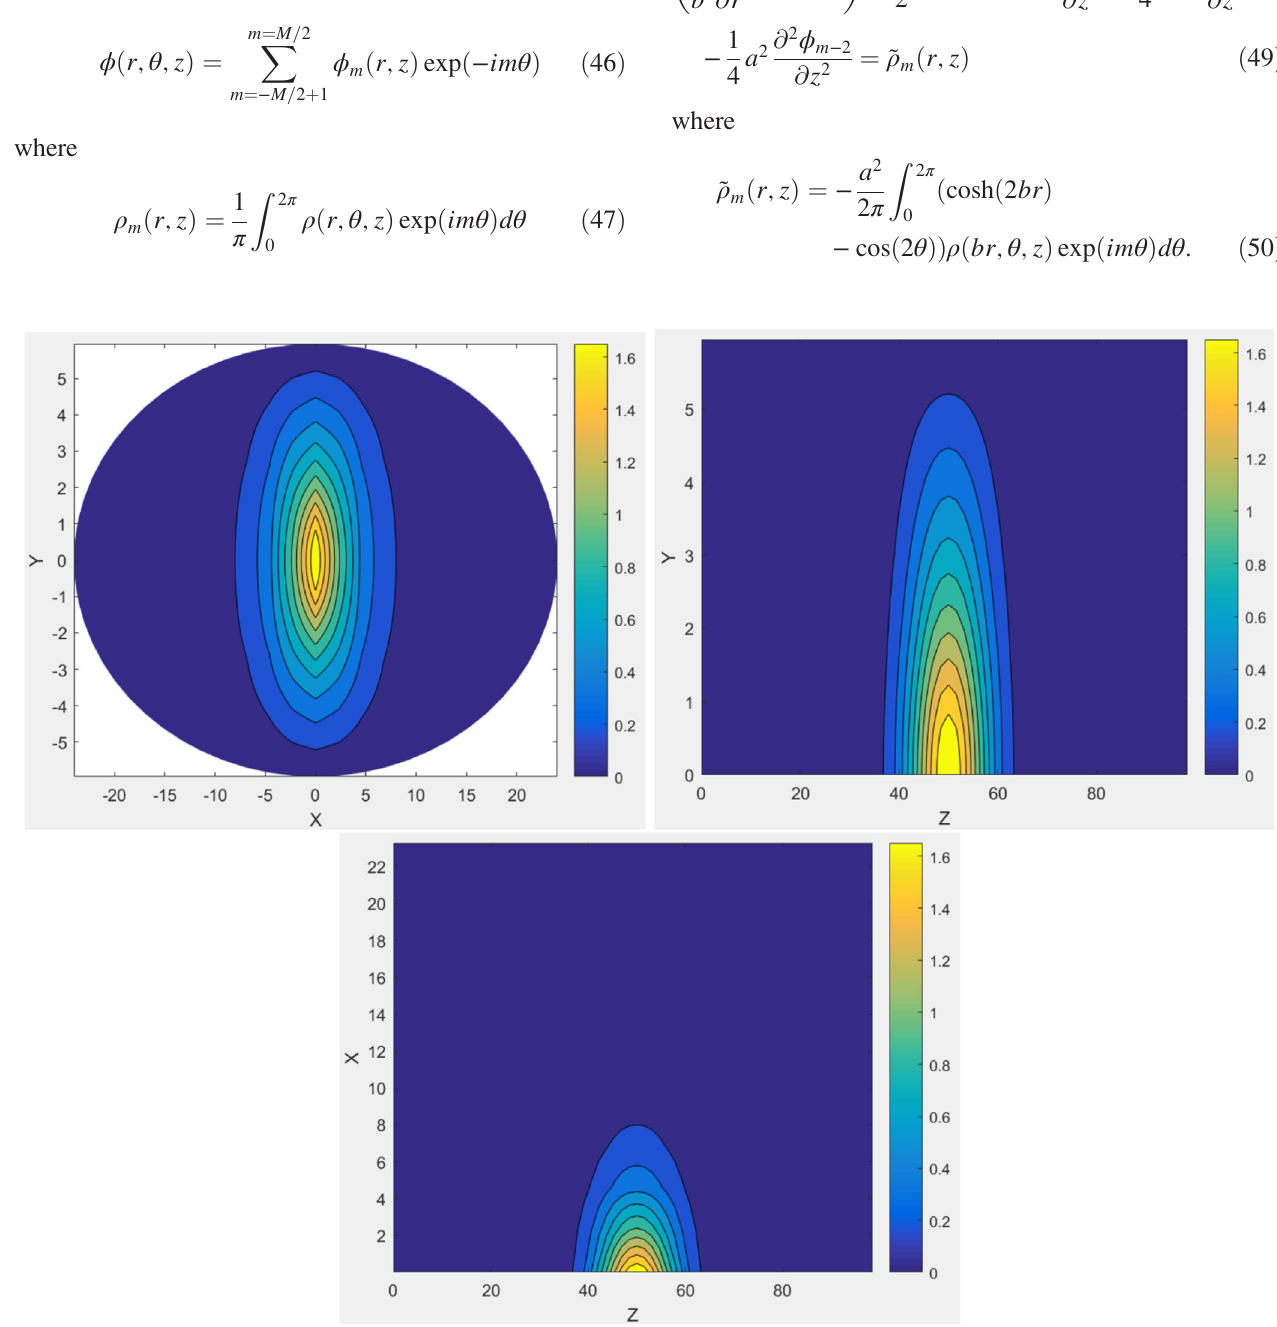
FIG. 8. The normalized electric potentials in the middle X − Y plane (upper left), the middle Z − Y plane (upper right) and the middle Z − X plane (bottom) from the spectral-finite difference method using a 3D bunched Gaussian density distribution with longitudinal open boundary condition and transverse elliptical conducting